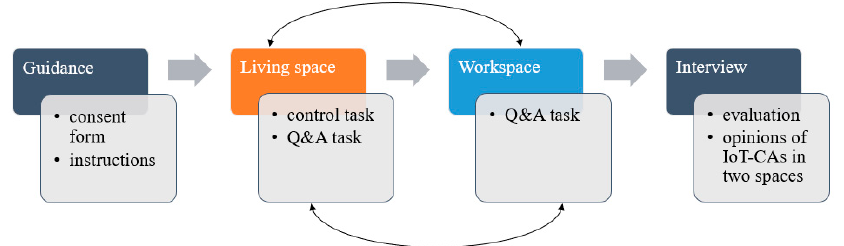
Figure 1. Experimental procedure of Experiment 1.